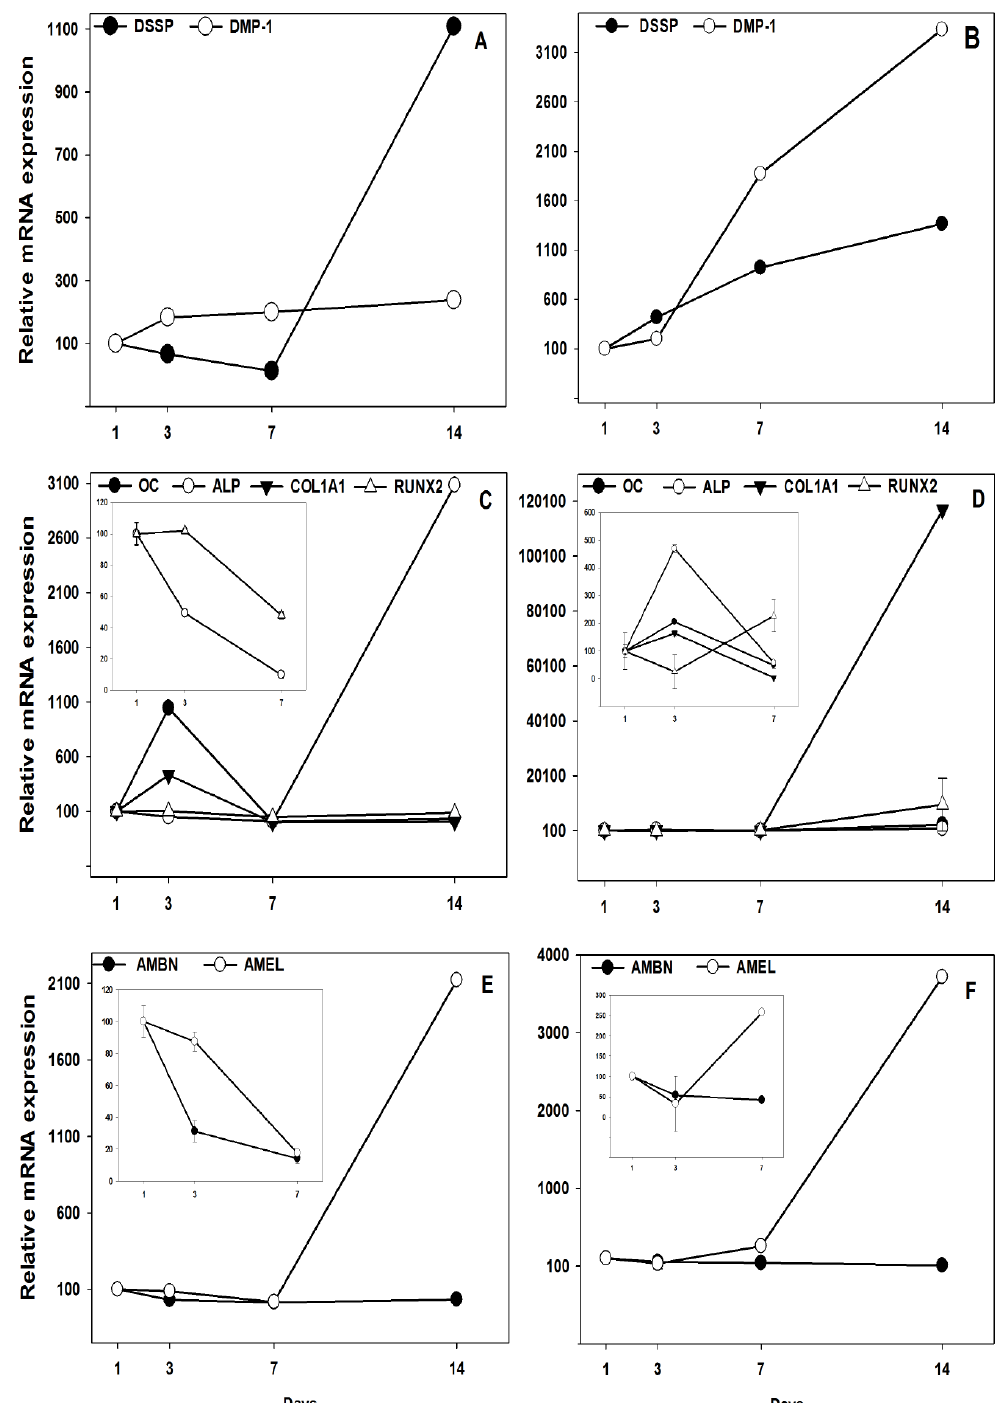
Figure 1. Effect of Enamel matrix derivative (EMD) (10 μ g/mL) on mRNA expression of dentin sialophosphoprotein (DSSP) and dentin matrix acidic phosphoprotein 1 (DMP-1) ( A ) (left panel) and dexamethasone (DEX) (10 − 8 M) ( B ) (right panel), osteocalcin (OC), alkaline phosphatase (ALP), runt-related transcription factor 2 (RUNX2) and collagen type 1 (COL1A1) ( C ) (left panel) and DEX (10 − 8 M) ( D ) (right panel); and amelogenin (AMEL) and ameloblastin (AMBN) ( E ) (left panel) and DEX (10 − 8 M) ( F ) (right panel) in primary human pulp cells. The data is presented as mean ± SD and calculated in percentage of untreated cells (100%) at each time